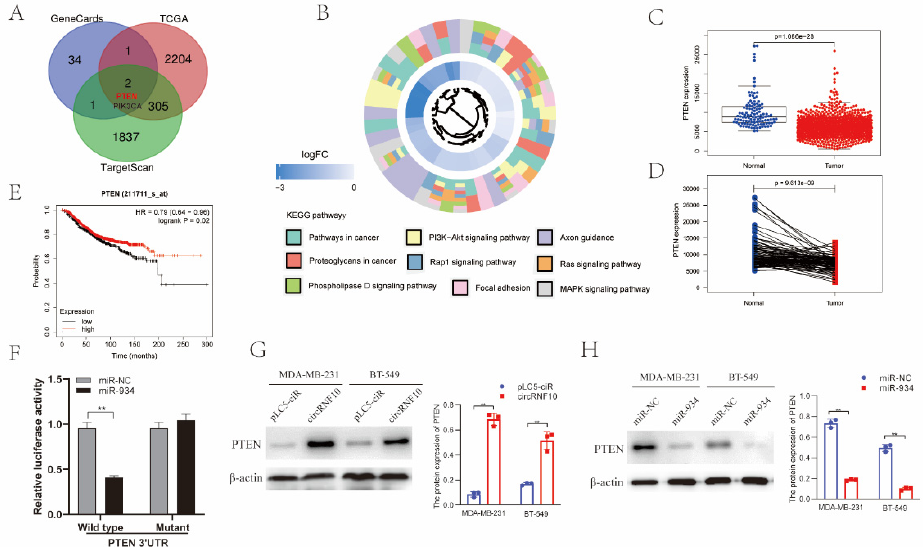
Figure 6. PTEN was the target gene of miR-934. ( A ) Potential targets of miR-934 were predicted based on TargetScan, GeneCards, and TCGA databases. ( B ) KEGG signaling pathway analysis of miR-934 target genes. ( C ) Expression of PTEN mRNA in 1109 BC specimens and 113 normal specimens was determined based on the TCGA database. ( D ) mRNA level of PTEN in 112 pairs of BC and normal tissues was determined based on the TCGA database. ( E ) Association between PTEN expression and OS in BC was determined by the Kaplan–Meier Plotter database. ( F ) Luciferase reporter activity of MDA-MB-231 cells co-transfected with luciferase reporters containing wild-type or mutant PTEN 3 ′ UTR vector and miR-934 mimics or NC was detected by the dual-luciferase reporter assay. ** p < 0.01. ( G ) Protein levels of PTEN in circRNF10 overexpression systems were observed by Western blotting. ** p < 0.01. ( H ) Protein levels of PTEN transfected with miR-NC or miR-934 mimics were investigated by Western blotting. ** p < 0.01. The uncropped western blot figures for relevant results are shown in Figure S1.